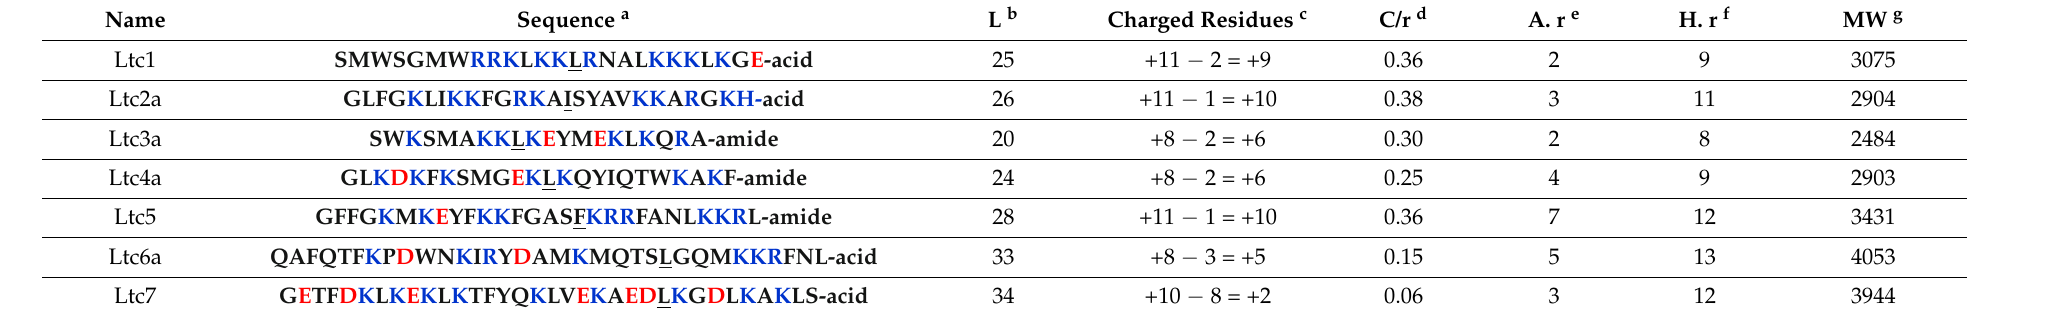
Table 1. Sequences and properties of the seven latarcin